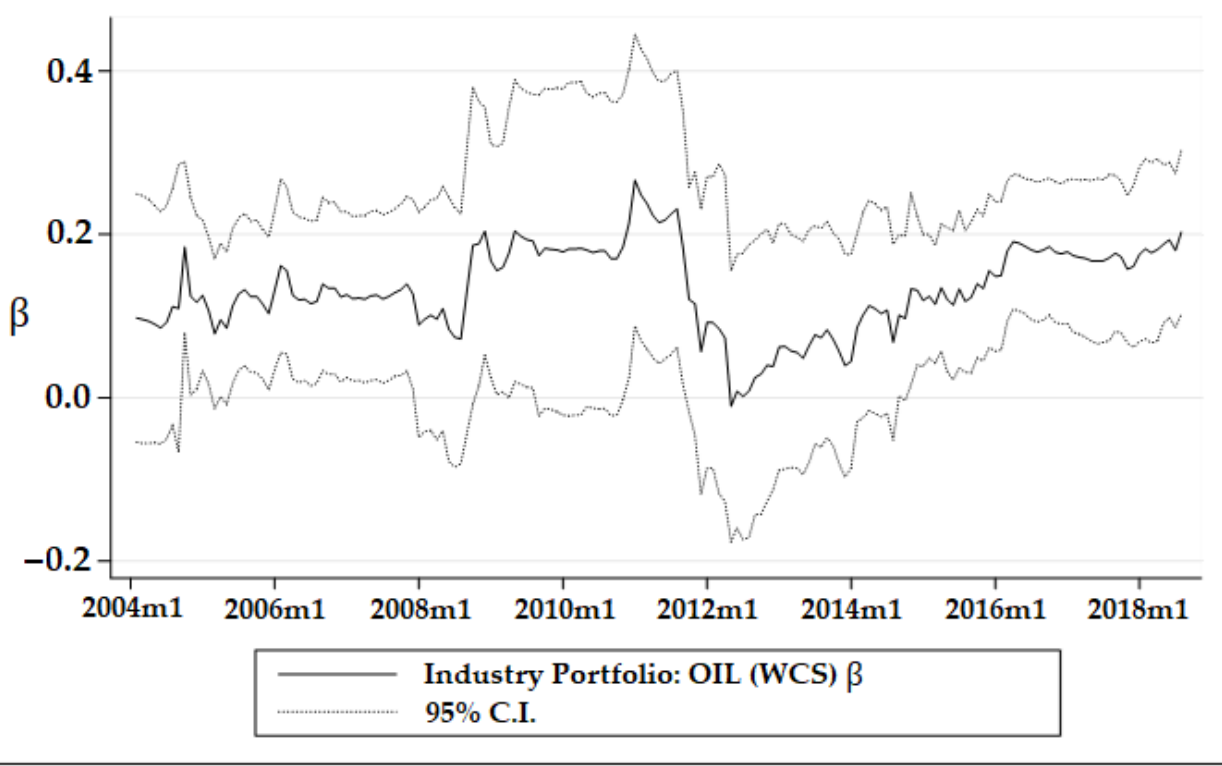
Figure 3. Time varying oil price beta (36-month average ( Δ WCS)).